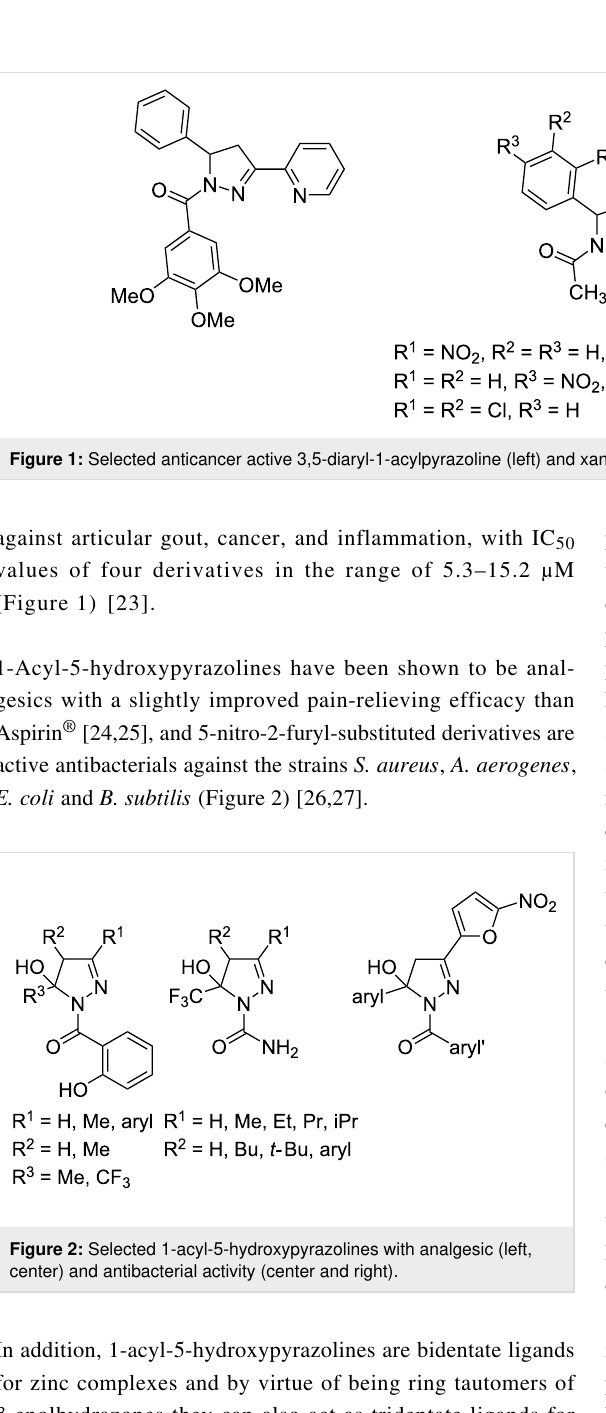
In addition, 1-acyl-5-hydroxypyrazolines are bidentate ligands for zinc complexes and by virtue of being ring tautomers of β -enolhydrazones they can also act as tridentate ligands for nickel [28] and tin [29,30] complexes. In contrast, dimethylzinc forms dimeric complexes where the 1-acyl-5-hydroxypyrazo- line acts as a bidentate ligand [31]. Upon treatment with TMEDA mononuclear complexes with concomitant ring opening to give a seven-membered bidentate chelate are gener-